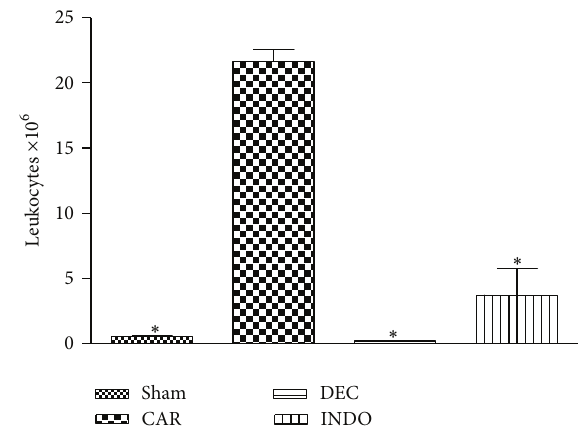
Figure 1: Effect of diethylcarbamazine (DEC: 50 mg/Kg, three days before) on cell migration in the initial phase (4h) of the inflam- matory reaction induced by carrageenan in mice; data expressed as mean ± S.E.M of 10 mice for each group; ∗ 𝑃 < 0.05 versus